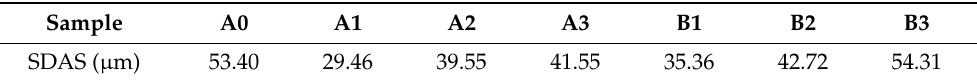
Figure 6. Strength and elongation of as-cast Al-9.5Si-1.5Cu-0.8Mn-0.6Mg alloy. Figure 7 showed the fracture surface by using SEM. Figure 7d–f showed the magni- fied shapes at the yellow dashed boxes of a–c, whereas the red solid box in Figure 7e was the magnified photos at the higher magnification. Figure 7a showed that the tensile frac- ture of the original alloy without refinement was relatively flat. The fracture morphology is mainly a smooth unraveling surface, almost without dimples and a few tearing edges